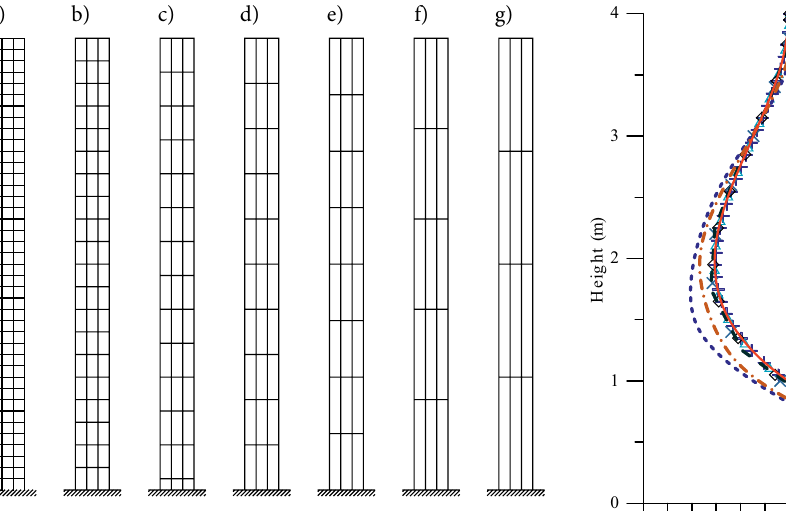
Fig. 4. FEM models with different aspect ratios (Ex.1)